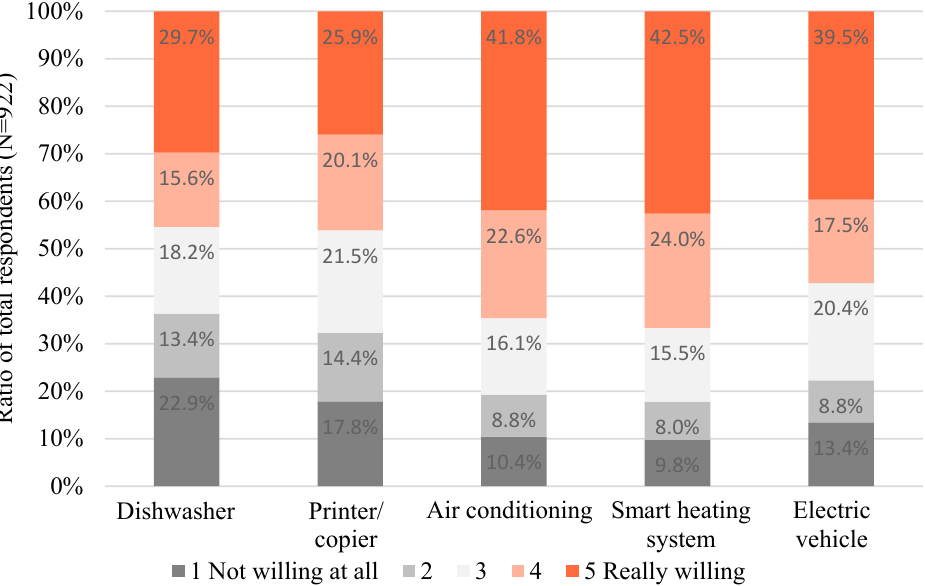
Figure 4. Willingness to let some smart appliances be remotely controlled by the electricity utility.